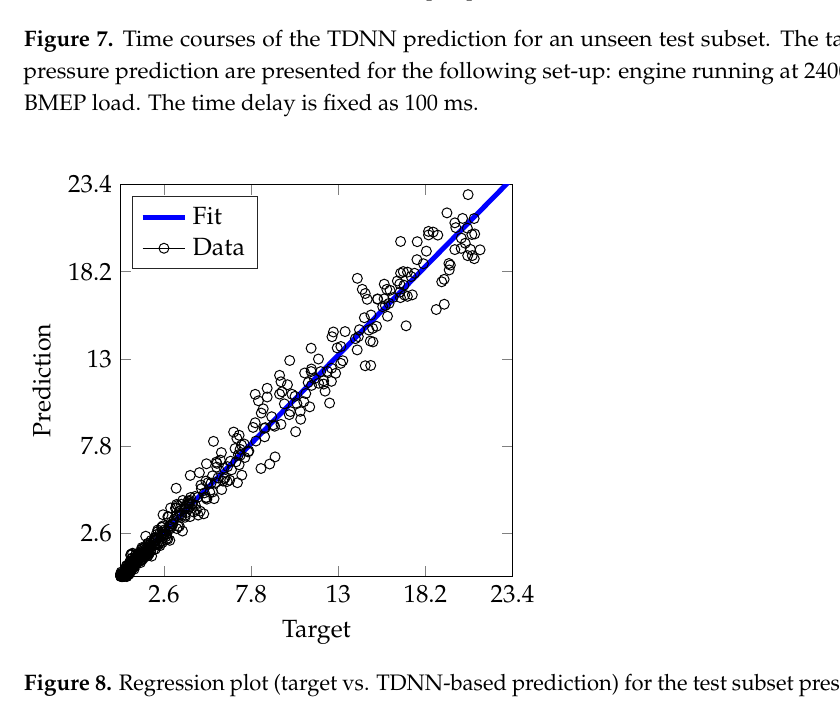
Figure 8. Regression plot (target vs. TDNN-based prediction) for the test subset presented in Figure 7. The o represents a given sample. Blue line: mean square error-based fitting (target vs. prediction along with the studied samples) holding a R 2 =